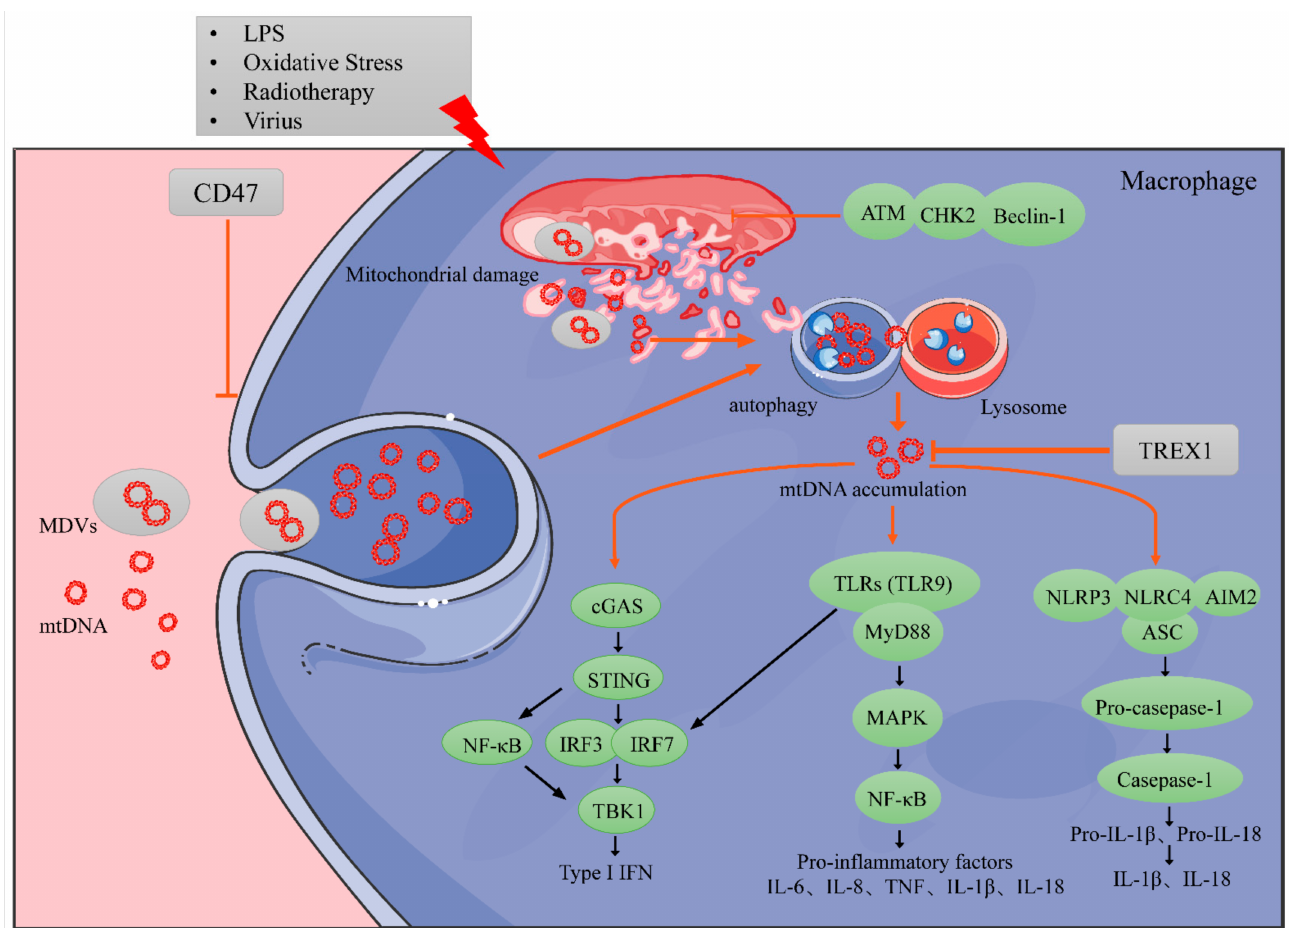
Figure 2. Source of mtDNA and immune responses in macrophages. MtDNA accumulation in macrophages: When tumors receive ionizing radiation, DNA-damaging drugs, and oxidative stress, the mitochondria of macrophages in the tumor microenvironments (TMEs) are damaged and release fragmented mtDNA. On the other hand, macrophages recognize the damaged mtDNA from tumor cells as exogenous foreign bodies and engulf them through endocytosis or MDVs. When activated, antigenic surface determinant protein OA3 (CD47) inhibits the phagocytosis of macrophages. The efficient fusion between phagosomes and lysosomes in macrophages results in rapid acidification of the phagosomal lumen and degradation of mtDNA. The three initial repair exonuclease 1 (TREX1), located in the cytoplasm of phagocytes, also degrades mtDNA in the cytoplasm. Inflammatory responses caused by mtDNA accumulation in macrophages: When mtDNA accumulates to a certain threshold, it can act as the damage-associated molecular pattern (DAMP) of cells and trigger inflam- matory responses as well as cause innate immunity, including activating the cGAS-STING pathway, inducing the transcription and secretion of type I interferons, and promoting the production of a variety of pro-inflammatory cytokines when recognized by toll-like receptors (TLRs) and activated inflammatory